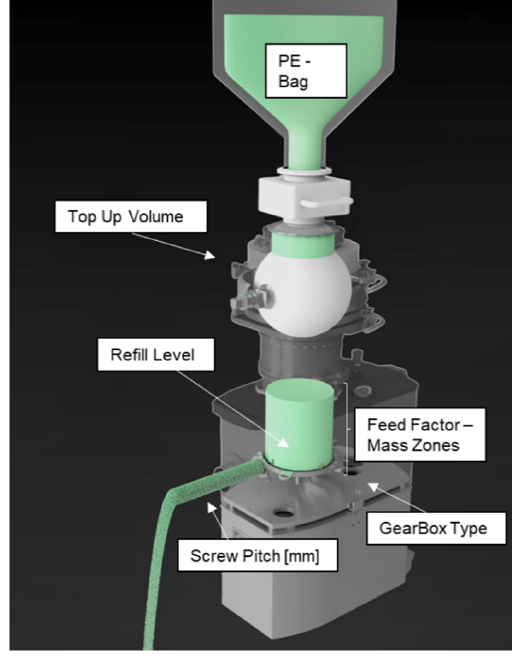
Figure 2. Overview of a GEA Compact Feeder and corresponding adjustment options.